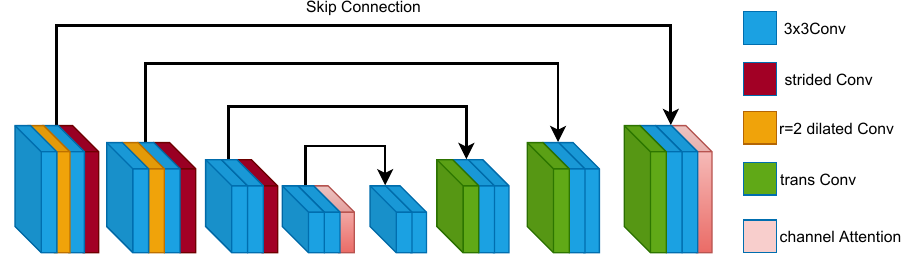
Figure 4. The attention-based asymmetric U-Net in the proposed